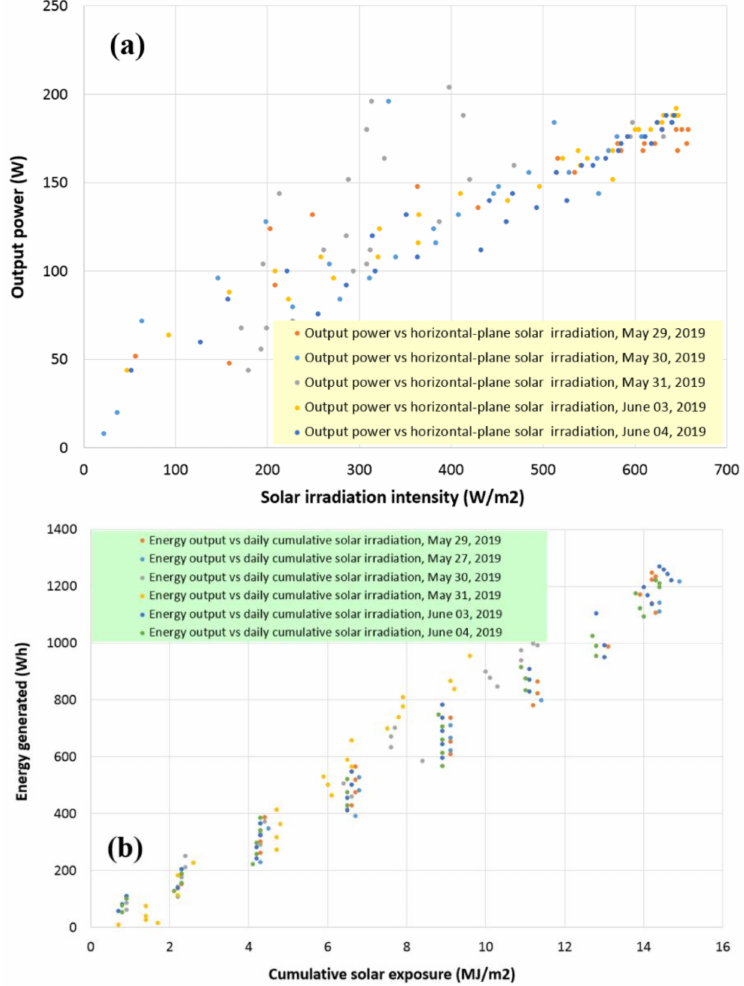
Figure 5. Energy harvesting performance vs solar exposure parameters. ( a ) Output power vs solar irradiation intensity measured in the horizontal plane by a local weather station; ( b ) generated electric energy vs daily land-area cumulative solar exposure (measured by the same weather station since midnight of the same